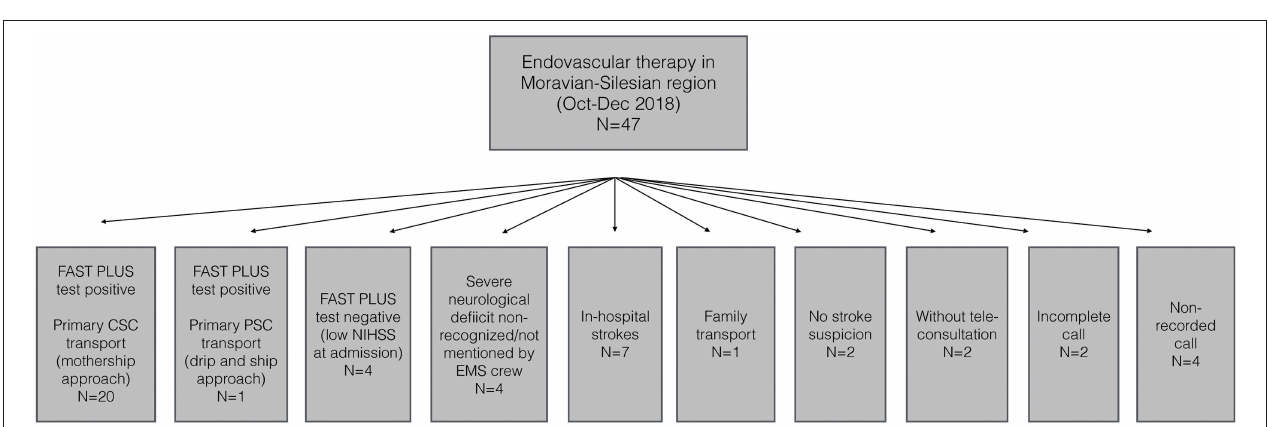
FIGURE 1 | Flow chart of stroke teleconsultation content analysis.